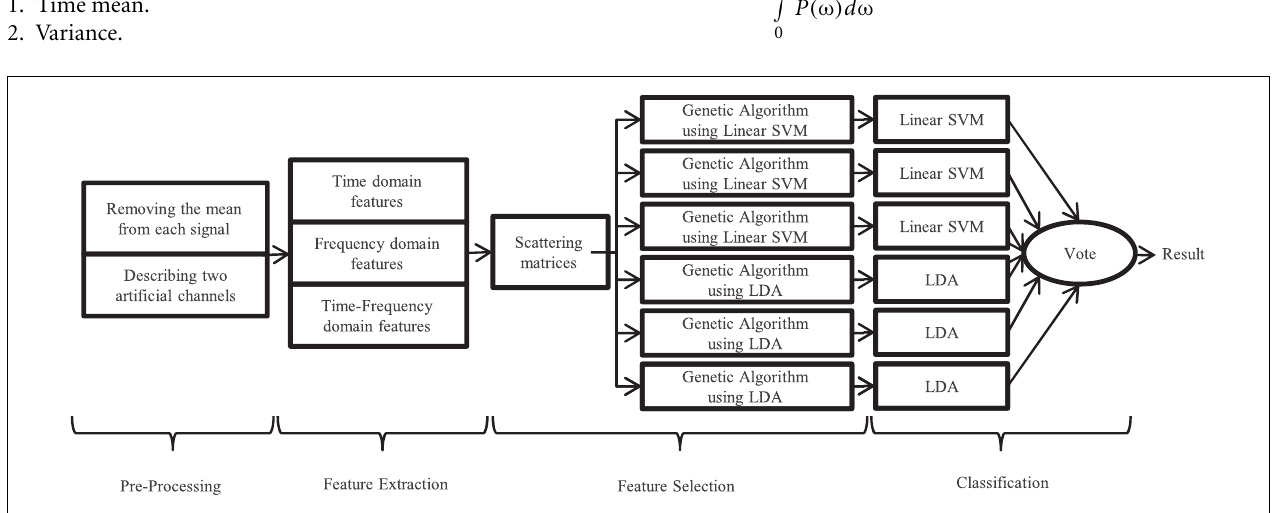
FIGURE 1 |The summarized flow chart of the different stages of the proposed algorithm.